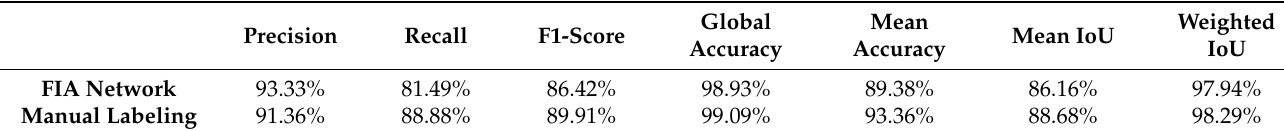
Table 3. Comparison between FIA net and the manual labeling net (precision, recall, F1-score, accuracy and IoU).